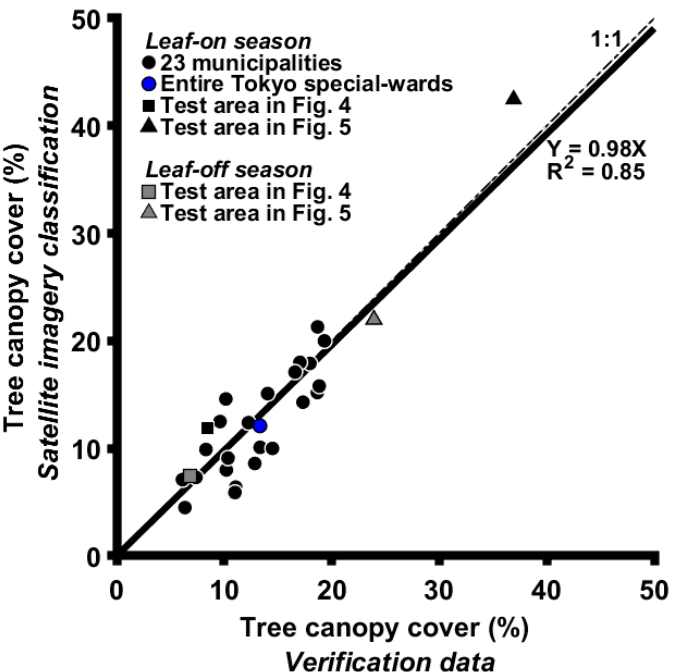
Figure 6. Image classification performance for tree canopy cover estimation. The plots represent the ratio of tree canopy cover (%) estimated for various areas (two test areas, each of 23 municipalities in Tokyo special-wards, and all Tokyo special wards) in comparison with the respective verification data derived from the field survey and aerial photographs.